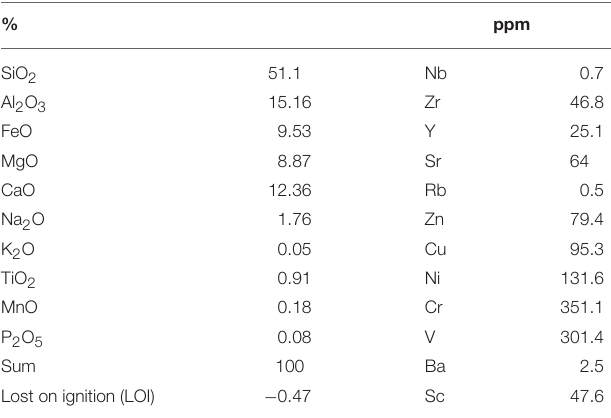
TABLE 2 | Composition of basaltic rock used in the